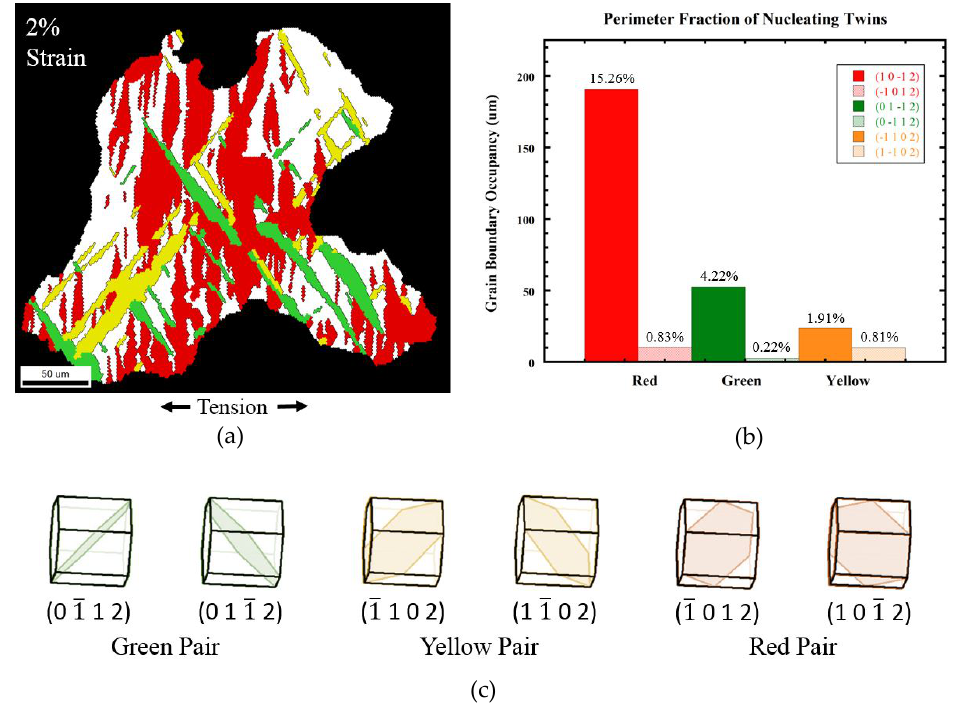
Figure 14. Twin variant selection in AOI 1. ( a ) The orientation map of the three evident twin pairs highlighted in green, yellow, and red. ( b ) By mapping the grain boundary occupancy of twins at 1% strain (just after nucleation), the perimeter fraction of twinning can be determined. The perimeter fraction shows a clear dominance of ( 1012 ) twinning with evident dominate variants within the green and yellow pairs, i.e., ( 0112 ) and ( 1102 ) respectively. ( c ) The proposed variant pair twin planes are shown within parent orientation with their respective colors.